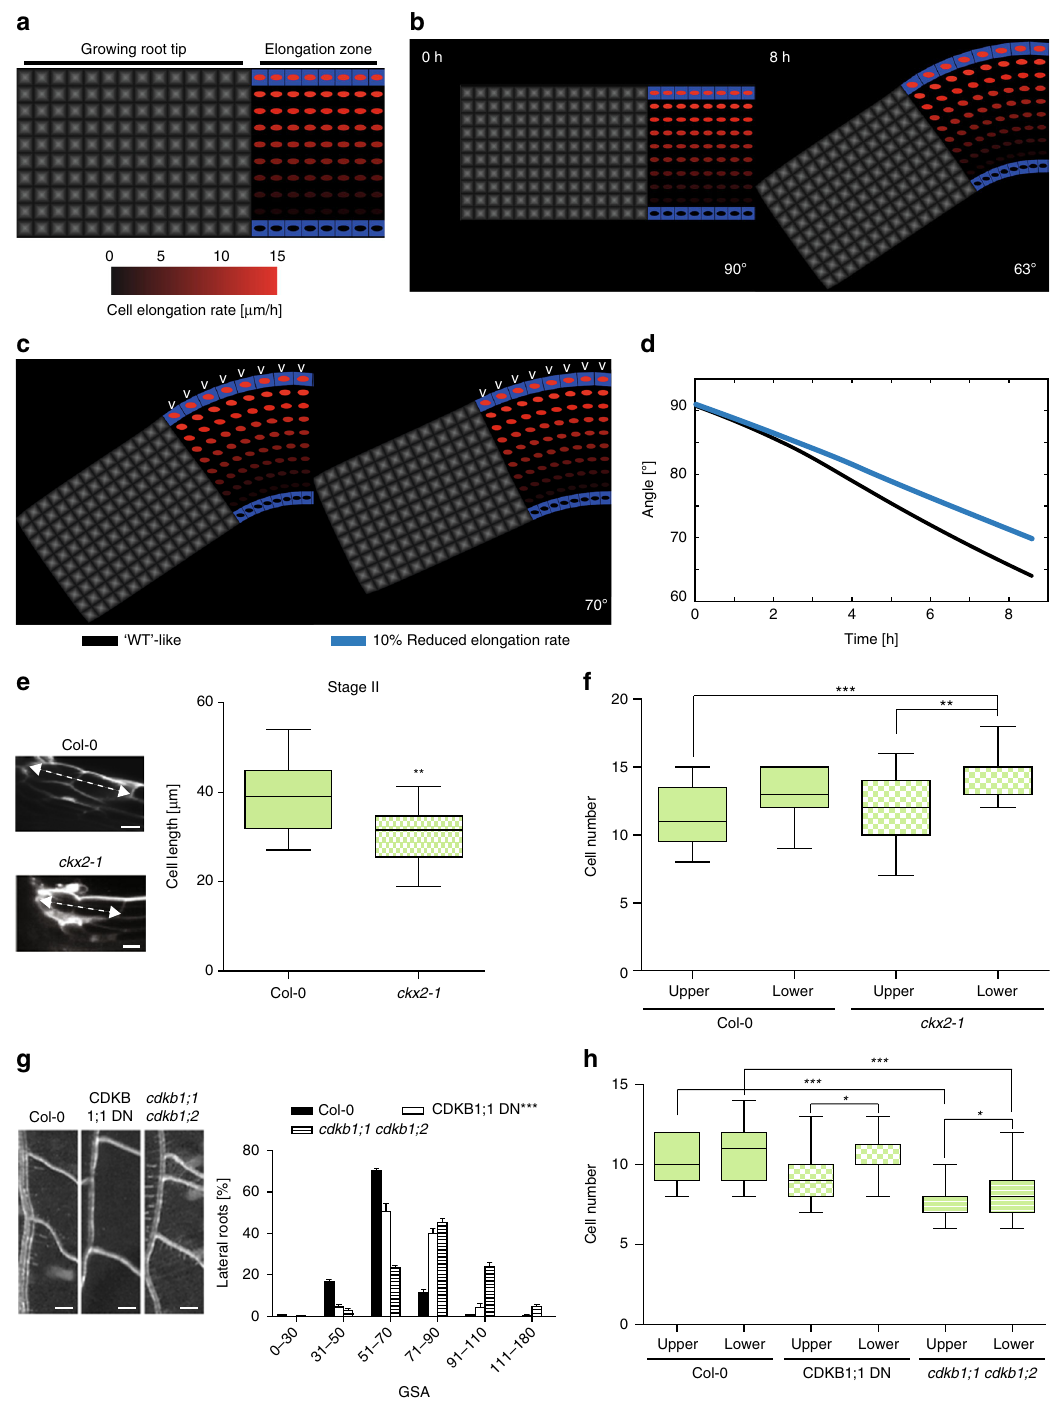
Fig. 7 Cytokinin affects cell elongation and number in lateral roots. a Sketch shows a simpli fi ed geometry of a lateral root (LR). LR model consists of tip and elongation zones. The cell elongation rate (visualized as red spot inside the cell) linearly increases from lower fl ank towards the upper fl ank of the LR (up to three-fold) based on estimates derived from previous work 7 . Bottom panel, color coding bar for cell elongation rates. b Time-lapse model simulations (screenshots) which lead to the in vivo observed LR bending (63°) after ~8 h. c Left panel corresponds to b . Right panel, 10% decrease in elongation rate only on the upper root fl ank (white arrow heads). Each simulation represents LR status after 9 h of dynamic elongation. d Time evolution of set-point angle corresponding to different scenarios in c . e Representative image and quanti fi cation of fi rst two elongated cells of lateral roots in stage II. f Quanti fi cation of the cell number in the upper and lower meristem of Col-0 and ckx2-1 . g Representative images and GSA distributions of Col-0 wild-type, CDKB1;1 DN (dominant negative) and cdkb1;1 cdkb1;2 . Kolmogorov – Smirnov test P -values: *** P < 0.001 (compared to Col-0 ). Mean ± SEM, n = 5 plates (16 seedlings with 100 – 180 LRs per plate). Scale bars, 2 mm. h Quanti fi cation of the cell number in the upper and lower meristem of Col-0 , CDKB1;1 DN and cdkb1;1 ckdb1;2 . e , f , h One-way ANOVA P -values: * P < 0.05, ** P < 0.01, *** P < 0.001. Horizontal lines show the medians; box limits indicate the 25th and 75th percentiles; whiskers extend to the min and max values, n = 10 – 20 individual LRs. Scale bar, 10 µ m. e – h Experiments were repeated at least three